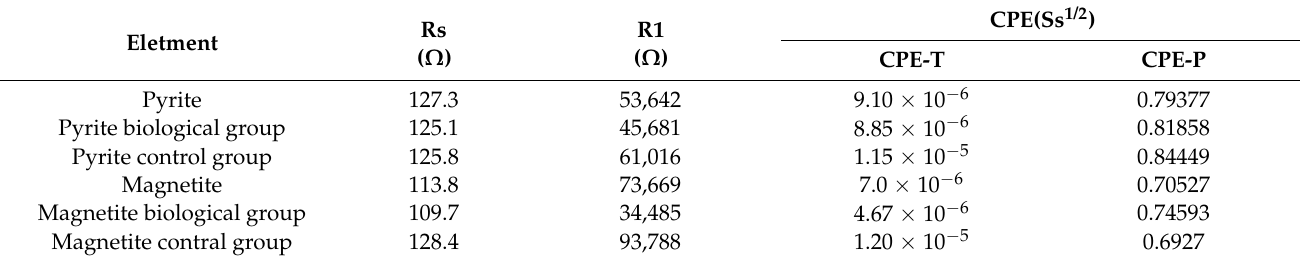
Table 3. Impedance parameters for the equivalent circuit.